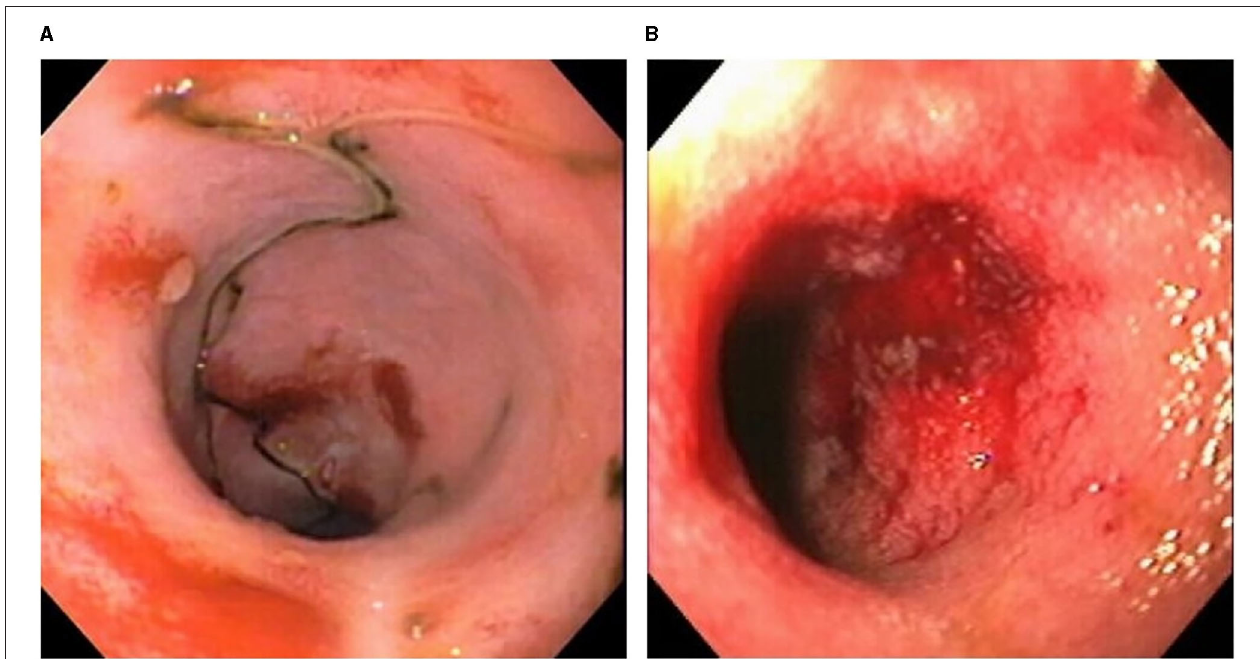
FIGURE 3 | Endoscopic evidence of intestinal barrier disruption in dogs with CIE. Multifocal erosions are evident within the ileal (A) and colonic (B) mucosae of different dogs with moderate-to-severe CIE. From: Jergens et al. ( 125), with permission.